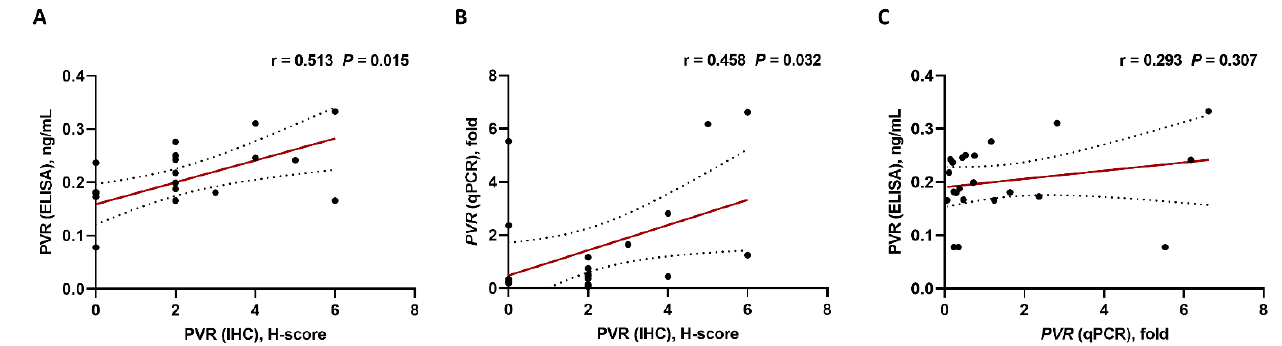
Figure 3. Correlations based on PVR expression using different detection methods (n = 22). ( A ) IHC vs. ELISA, ( B ) IHC vs. qPCR, and ( C ) qPCR vs. ELISA. Pearson’s or Spearman’s correlation coefficients (r) were used for analyses. Black ball, raw data; red line, linear fit line; dotted line, 95% confidence band. ELISA, enzyme-linked immunosorbent assay; IHC, immunohistochemistry; qPCR, quantitative polymerase chain reaction.